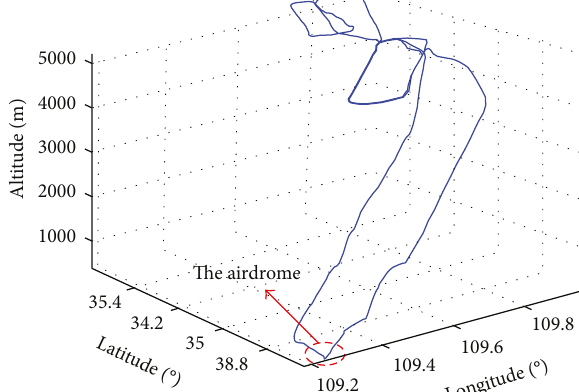
Figure 4: The fl ight trajectory of the experiment in Shaanxi Province, China, April 2017.